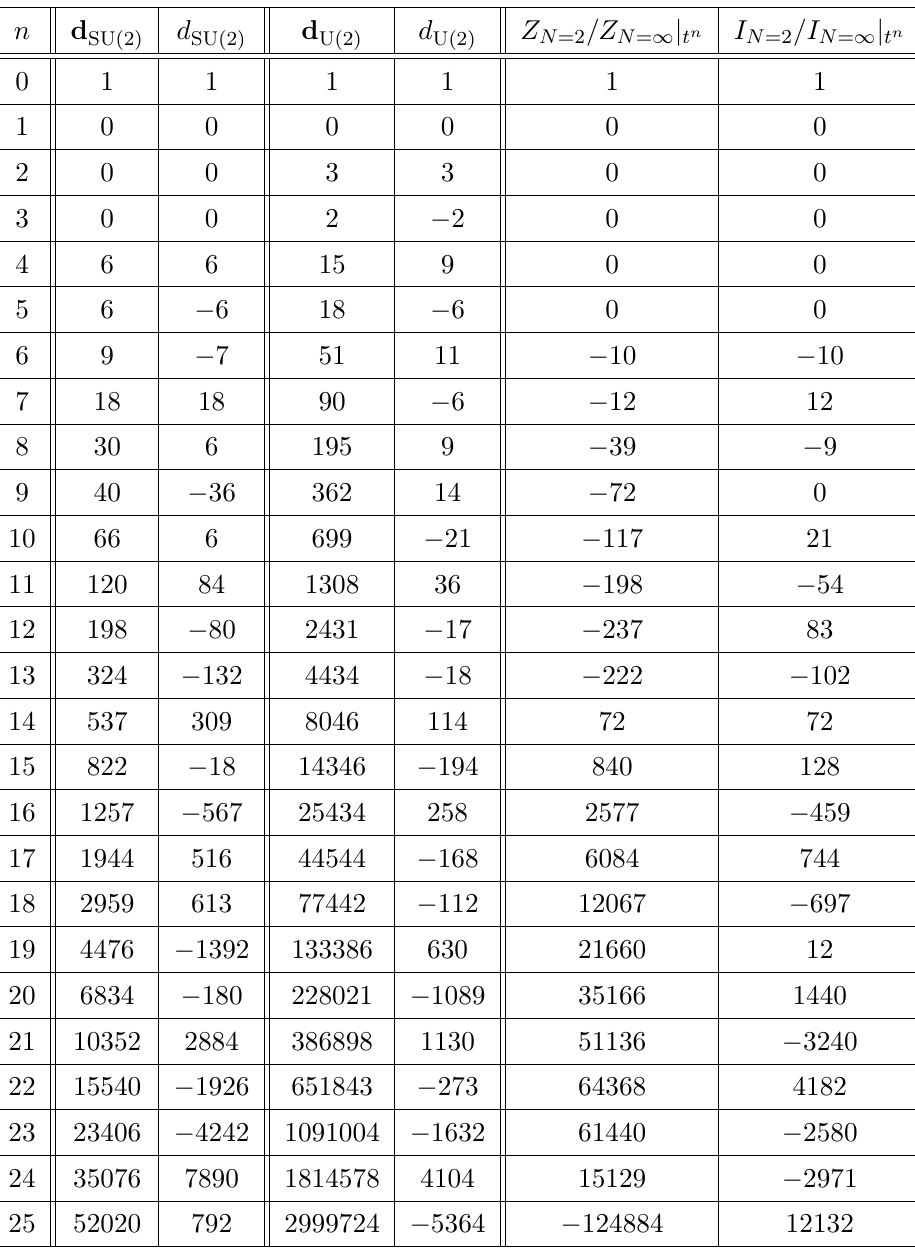
Table 3 . Counting of 1/16-BPS states for SU(2) and U(2) gauge groups, and the coefficients of Z N =2 /Z N = ∞ and I N =2 /I N = ∞